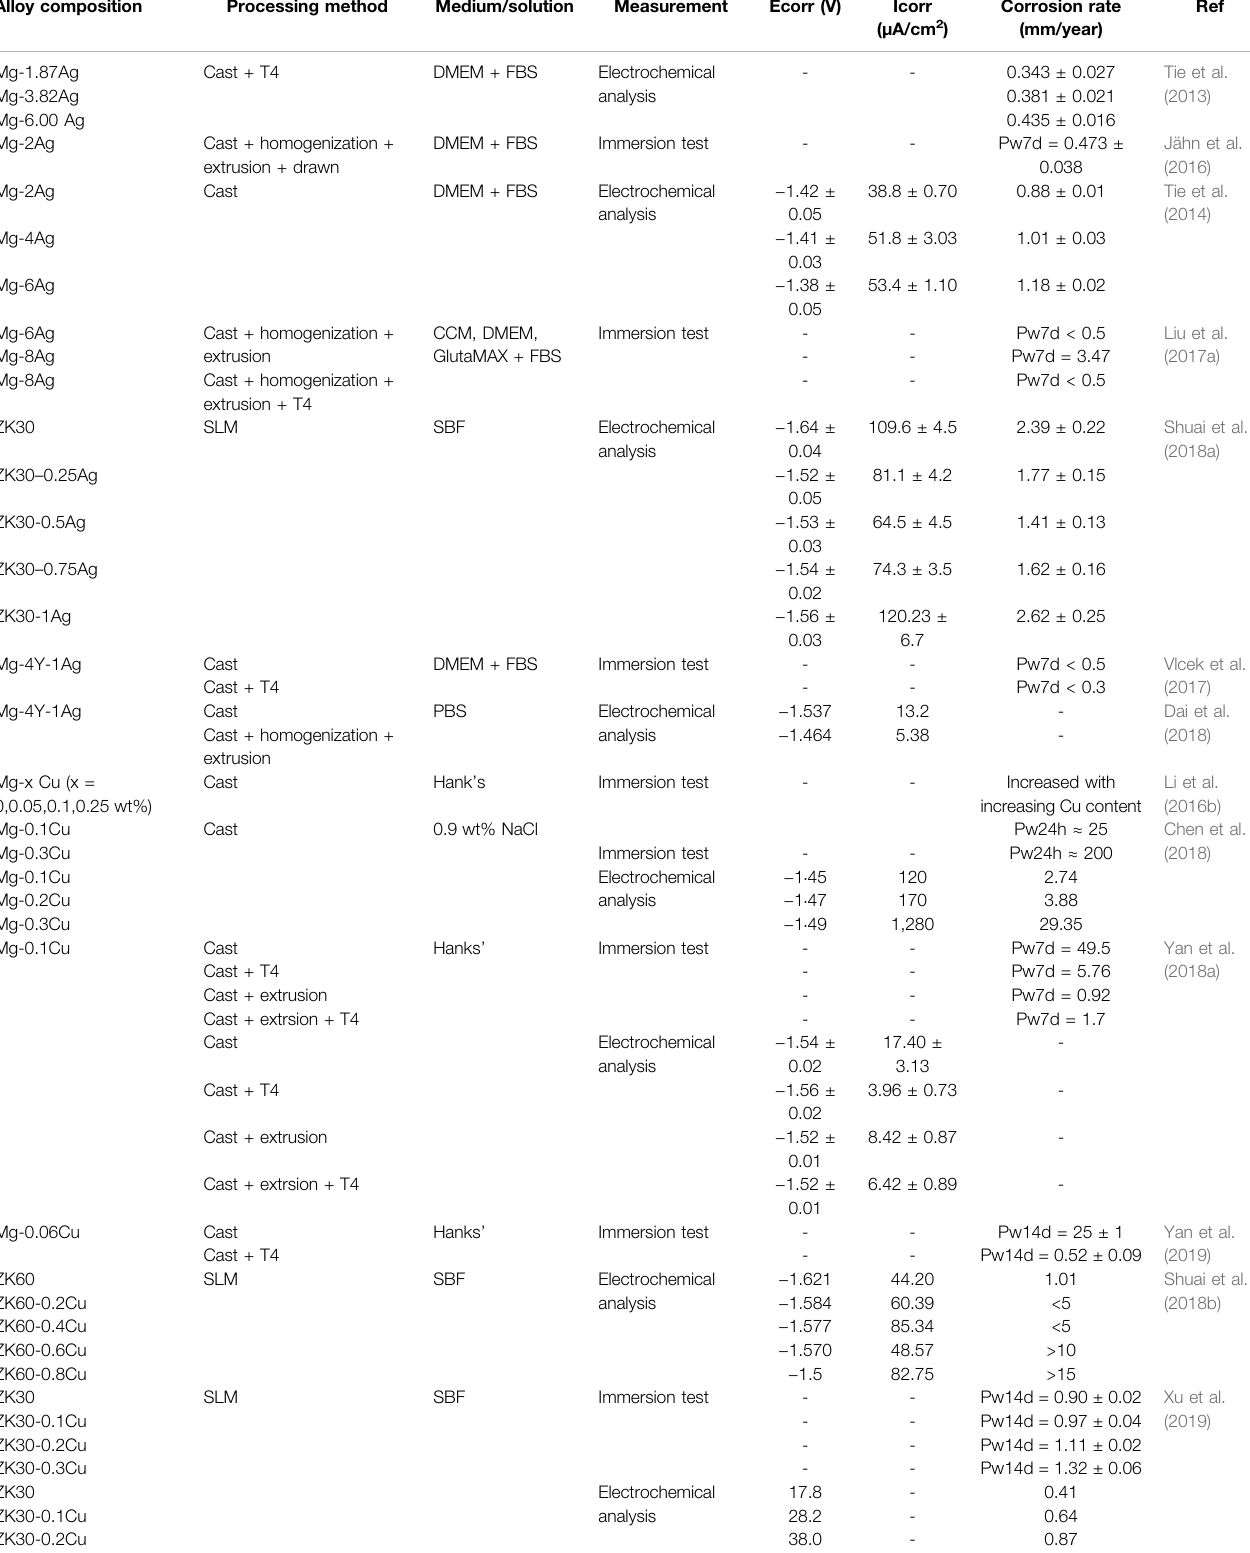
TABLE 3 | Corrosion resistance of Mg-based alloys with antibacterial properties as orthopedic implants. Alloy